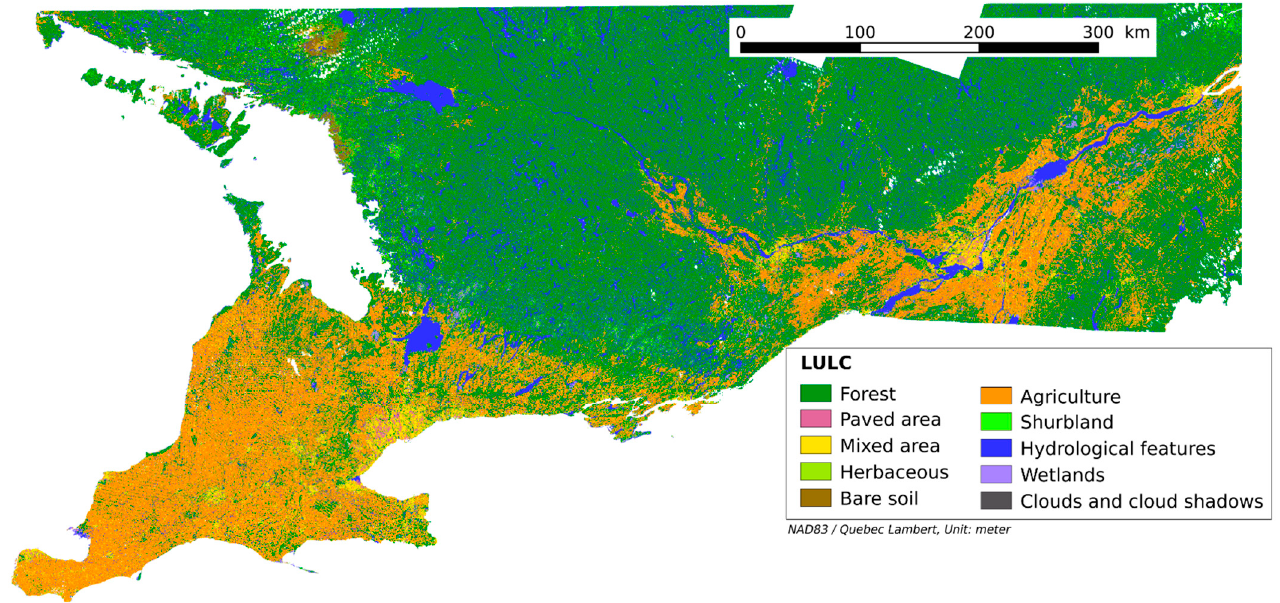
Figure A1. Resulted Land use land cover map.